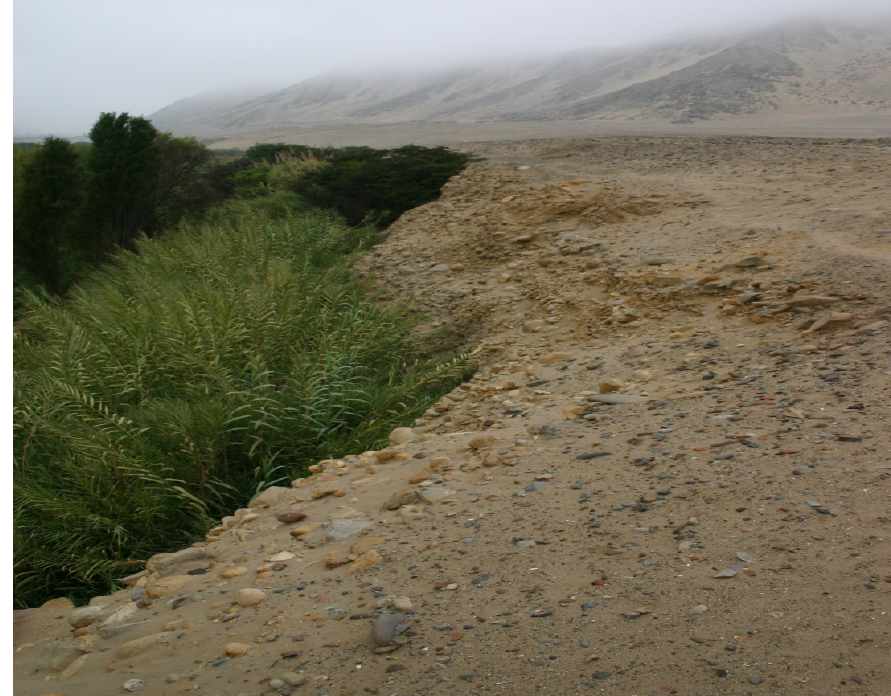
Figure 13. The plateau edge above the steep embankment leading from valley bottomlands to the plateau. Along the embankment (now hidden by brush) is the Ramped Canal indicated in Figure 3, leading to the early Chupacigarro interior valley site indicated in Figure 15.